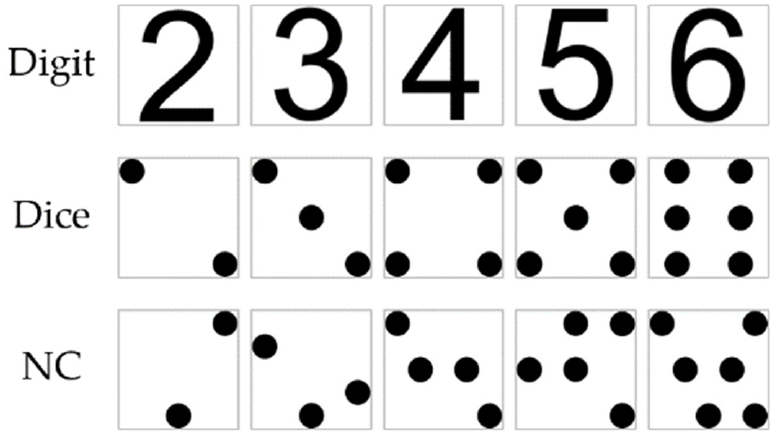
Figure 1. Three types of number stimuli for numbers 2–5. Grey lines delineate borders of stimuli area (2° × 2°, for illustration only), and were not present in the experiment.